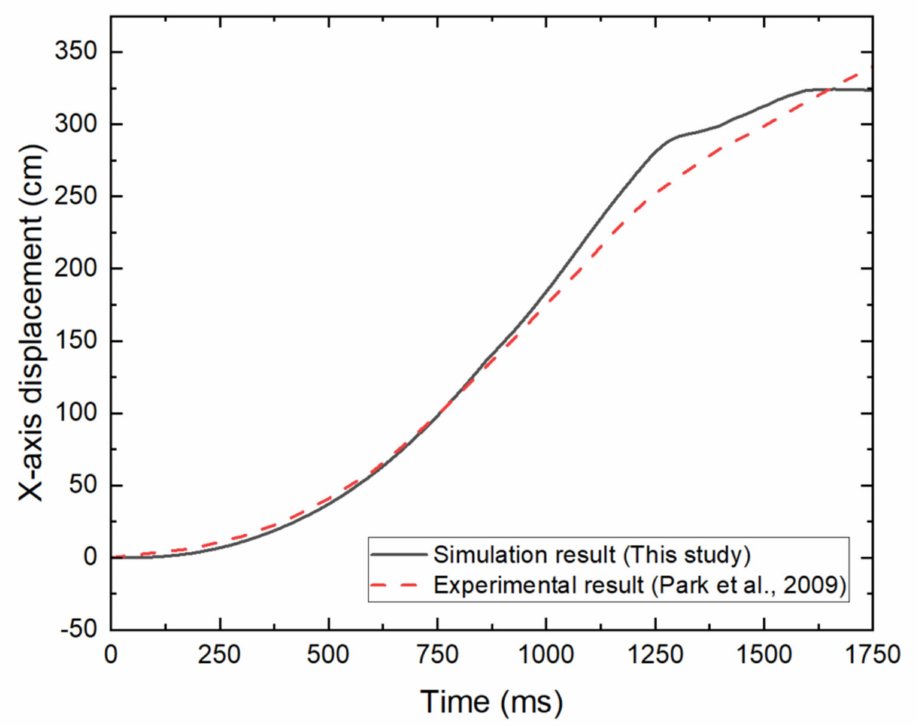
Figure 17. Comparison of the x-axis displacement in experiment and numerical simulation (This figure has been reproduced from [7] under the terms and conditions of the CC BY-NC